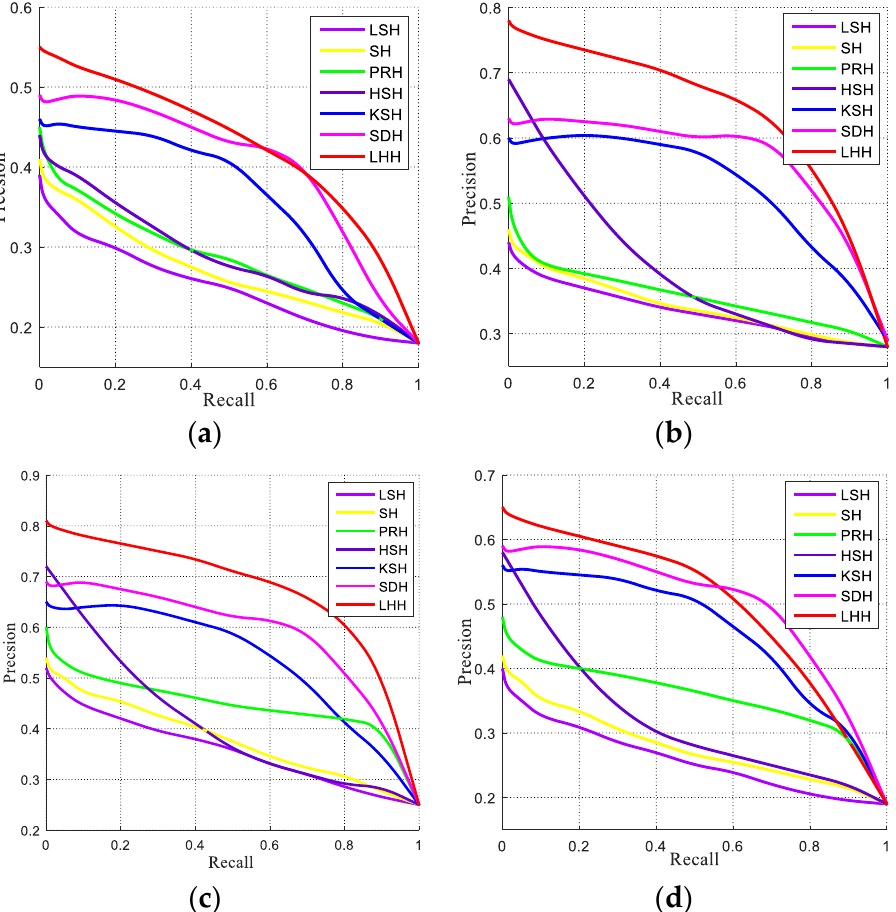
Figure 6. P-R curves of several hashing methods on (a) UCMD; (b) SAT4; (c) SAT6; and (d) CIFAR10.